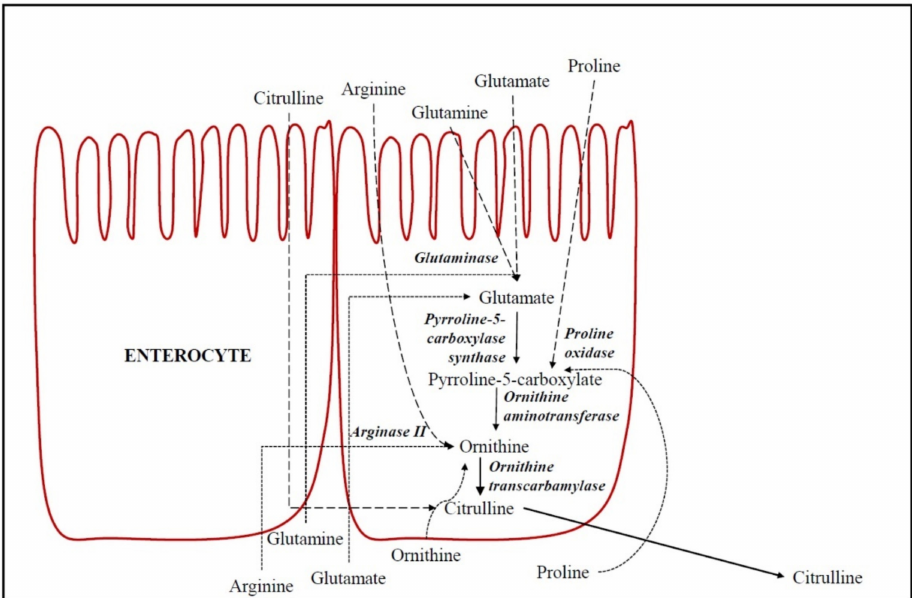
Figure 1. De novo formation of citrulline in epithelial absorptive cells of the small intestine (entero- cytes). Dashed lines indicate the amino acids flow from oral ingestion through enterocytes (apical transport) and dotted lines indicate the amino acids flow from portal blood through enterocytes (basolateral